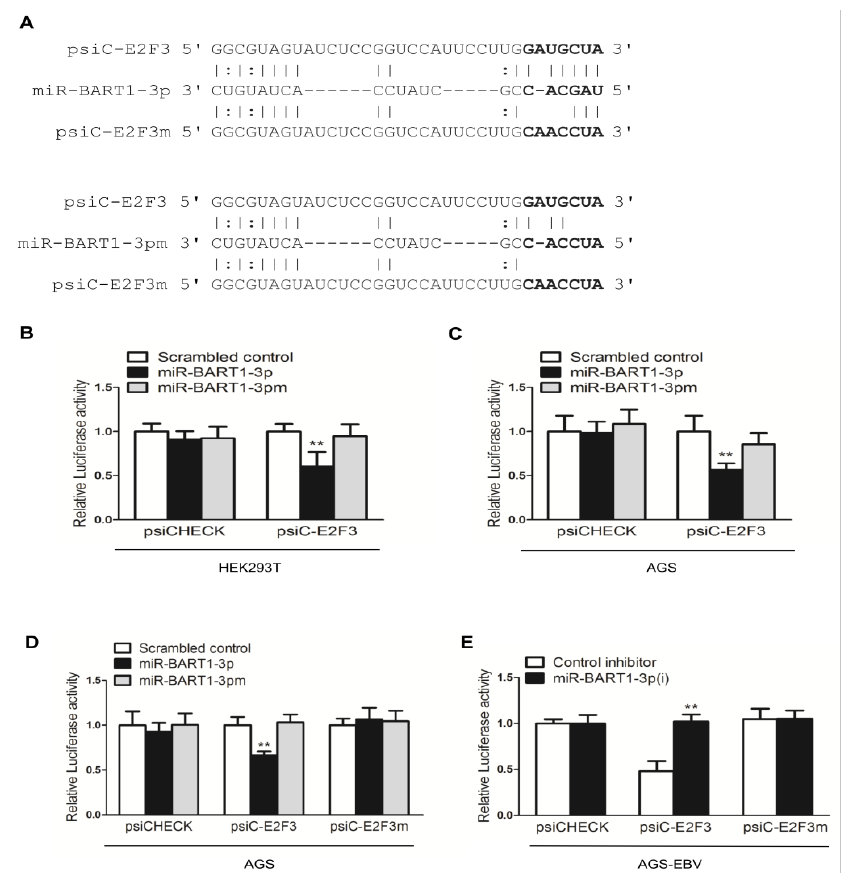
Figure 4. miR-BART1-3p targeting E2F3. ( A ) Seed match between miR-BART1-3p or miR-BART1-3pm and the luciferase reporter constructs containing the wild-type or the mutant 3 (cid:48) -UTR of E2F3. ( B ) Luciferase reporter assays. miR-BART1-3pm was used to check the specific binding between the miRNA mimics and the reporter constructs. The HEK293T cells were co-transfected with the miR-BART1-3p mimic or the miR-BART1-3pm and each of the luciferase reporter constructs containing the 3 (cid:48) -UTR of E2F3. The scrambled control and the empty reporter vector, psiCHECK, were included as controls. Luciferase activity was measured 48 hr after transfection and normalized using firefly activity. Error bars indicate the SD ( n = 3). ( C ) The AGS cells were co-transfected with 30 nM miR-BART1-3p mimic or the miR-BART1-3pm, and the appropriate luciferase reporter construct. ( D ) The AGS cells were co-transfected with 30 nM miR-BART1-3p mimic or miR-BART1-3pm and 20 ng appropriate luciferase reporter construct containing the wild-type or the mutant 3 (cid:48) -UTR of E2F3. ( E ) The AGS-EBV cells were co-transfected with 30 nM LNA-miR-BART1-3p(i) and 20 ng appropriate luciferase reporter construct containing the wild-type or the mutant 3’-UTR of E2F3. Luciferase activity was measured 48 hr after transfection, normalized using firefly luciferase activity, and expressed as a ratio compared with that of the scrambled control-transfected cells. The data were analyzed using ANOVA. Error bars indicate the SD ( n = 3). **, p <